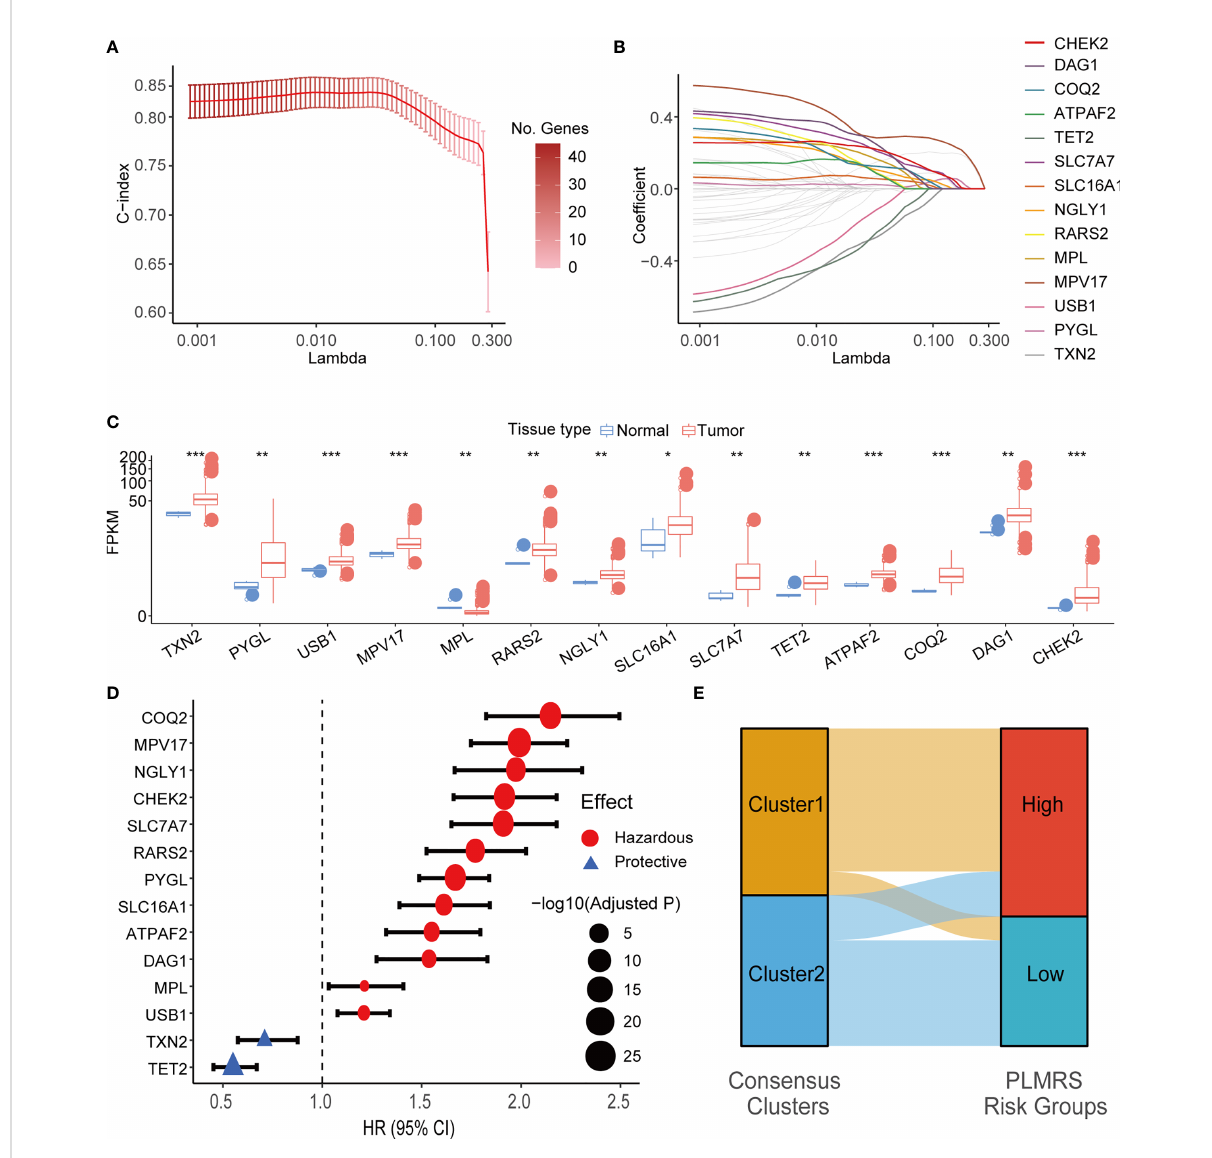
FIGURE 6 LASSO Cox regression and identi fi cation of PRLMGs. (A) Average of means and 95% con fi dence intervals of the C-index of LASSO Cox regression model at each lambda value. (B) Average of coef fi cients of LMGs in the LASSO Cox regression model at each lambda value. (C) mRNA expression of each PRLMG in glioma and normal brain tissue. (D) Univariate Cox regression analysis of PRLMGs in glioma prognosis. (E) Alluvial plot showing relationships between LMGs clusters and PLMRS risk groups. LASSO, Least Absolute Shrinkage and Selection Operator; C-index, concordance index; LMG, lactate metabolism-related gene; PRLMG, prognosis-related lactate metabolism gene. *P < 0.05; **P < 0.01; ***P <